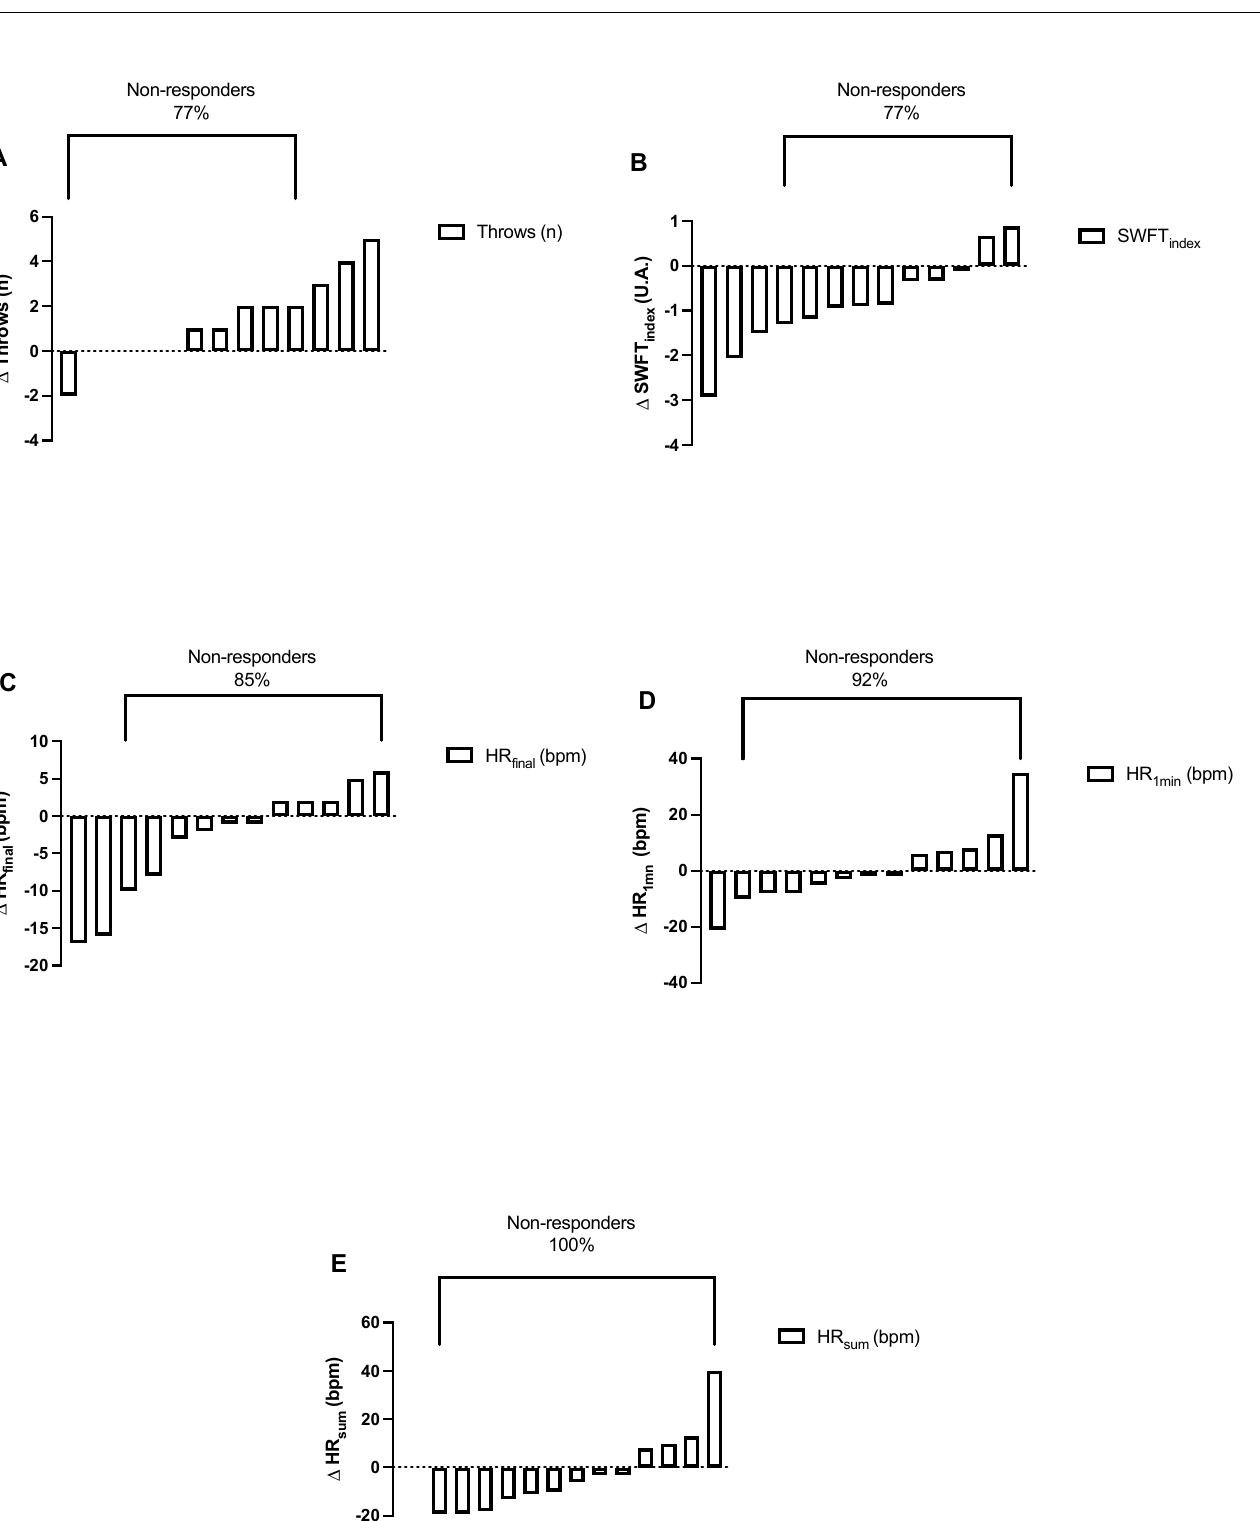
Figure 3. Individual pre–post change [ Δ ], after 6 weeks of multi-component training, for ( A ) Throws, ( B ): Special Wrestling Fitness Test index (SWFT index ) , ( C ) HR final (heart rate at the end of the SWFT), ( D ) HR 1min (heart rate at 1-min post SWFT), ( E ) HR sum (sum of HR final and HR 1min ). Table 3. Group pre–post change and responders after 6 weeks of multi-component training.